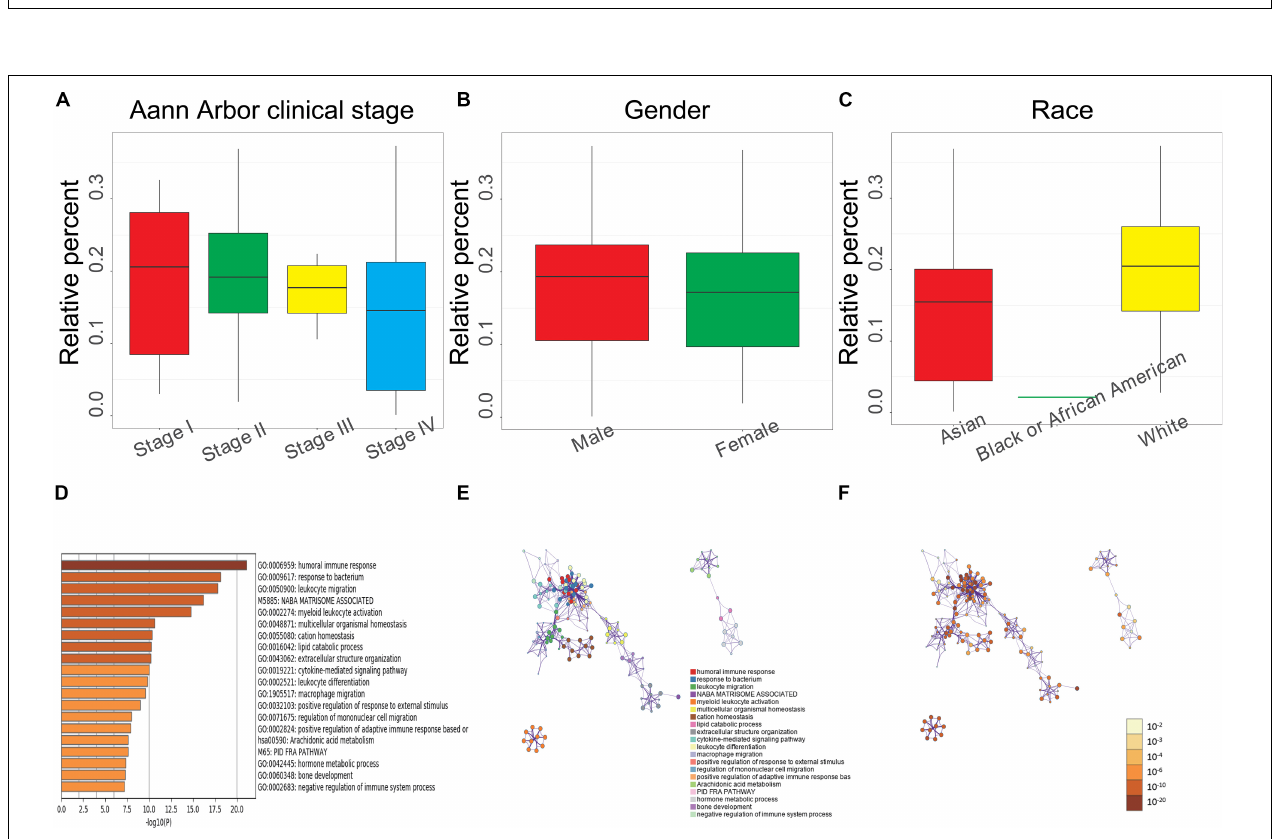
FIGURE 6 | (A) Relationship between the M0 macrophage abundance ratios and Ann Arbor clinical stage (Stage I, 8 samples; Stage II, 17; Stage III, 5; and Stage IV, 12; P = 0.692). (B) Relationship between M0 macrophage abundance ratios and gender (male, 22 samples; female, 26; P = 0.344). (C) Relationship between M0 macrophage abundance ratios and race (Asian, 18 samples; Black or African American, 1; White, 29; P = 0.043). (A–C) Each boxplot shows the median with the 25th and 75th percentiles. (D) Bar graph of enriched terms based on M0 macrophage abundance levels, colored by P- value. (E) Enriched terms network. Nodes are colored by cluster-ID and closeness to each other. (F) Enriched terms network. Nodes are colored by P- value.